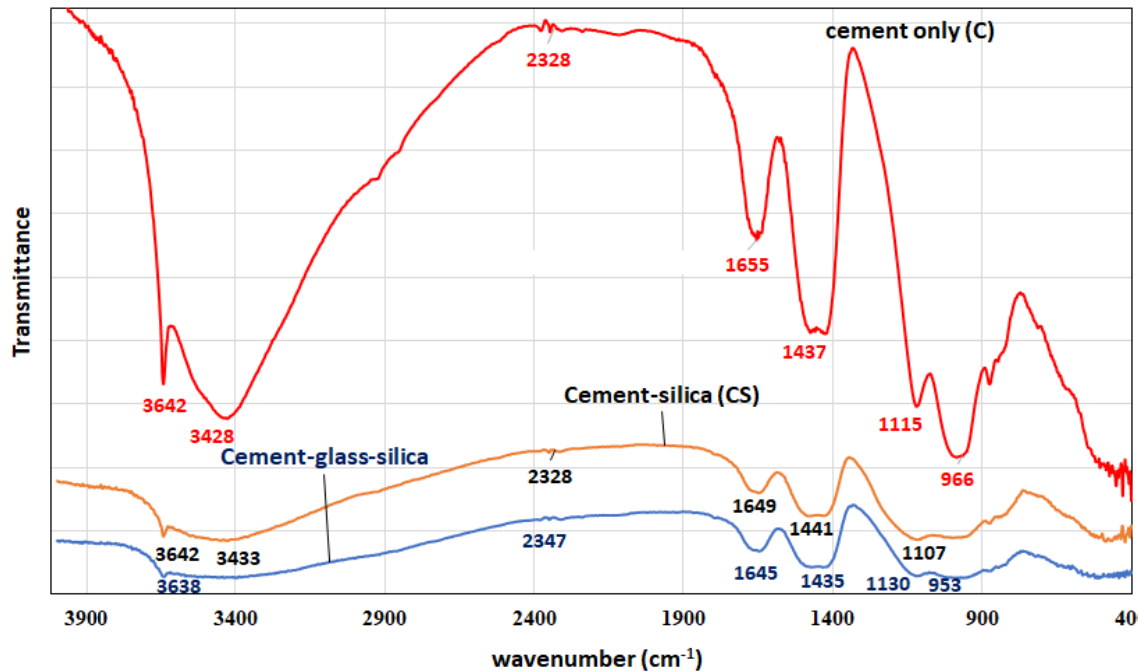
Figure 9. FTIR spectra of blended silica-fume/glass (ternary) cement (CGS − bottom), blended silica- fume (binary) cement (CS − middle) and hydrated cement (CC − top) paste.